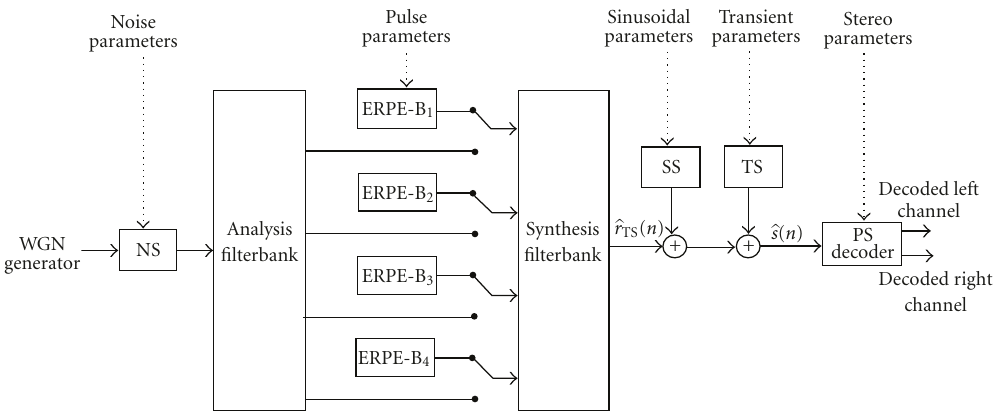
Figure 12: SSC-ERPE